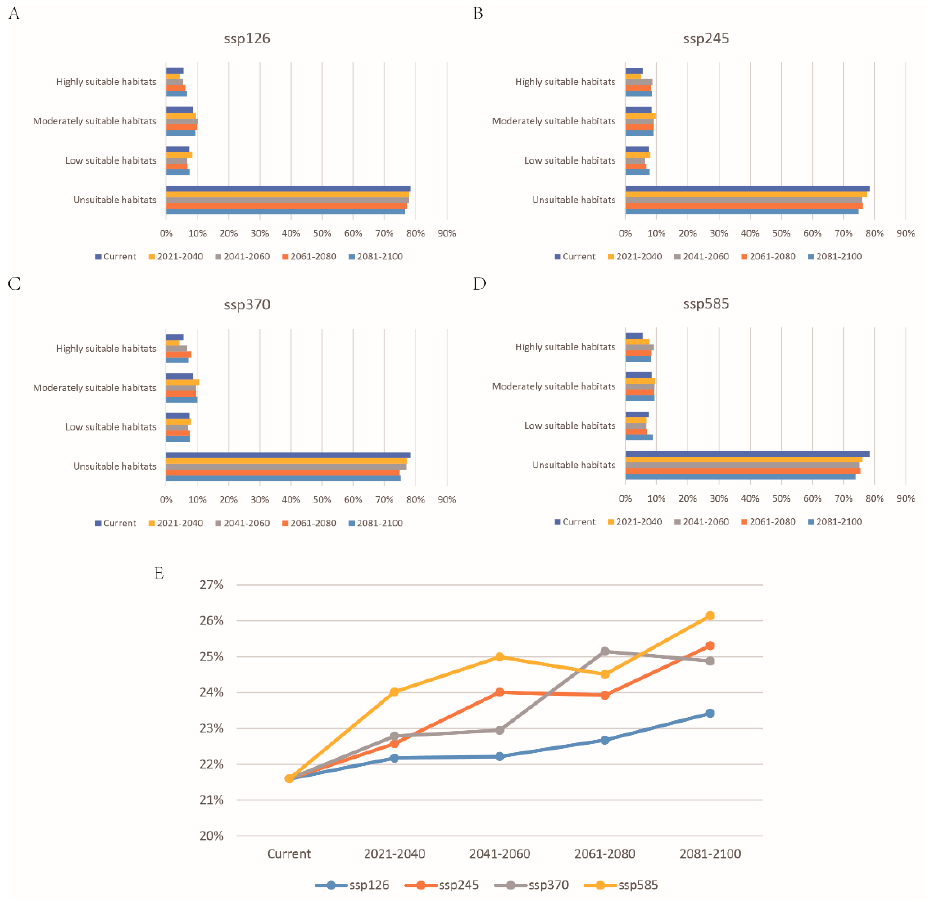
Figure 7. The proportion of suitable habitats for P. canaliculata under current and future climate change scenarios in China: ( A ) SSP126, ( B ) SSP245, ( C ) SSP370, and ( D ) SSP585; ( E ) change in the proportion of total suitable habitats (including low suitable, moderately suitable, and highly suitable